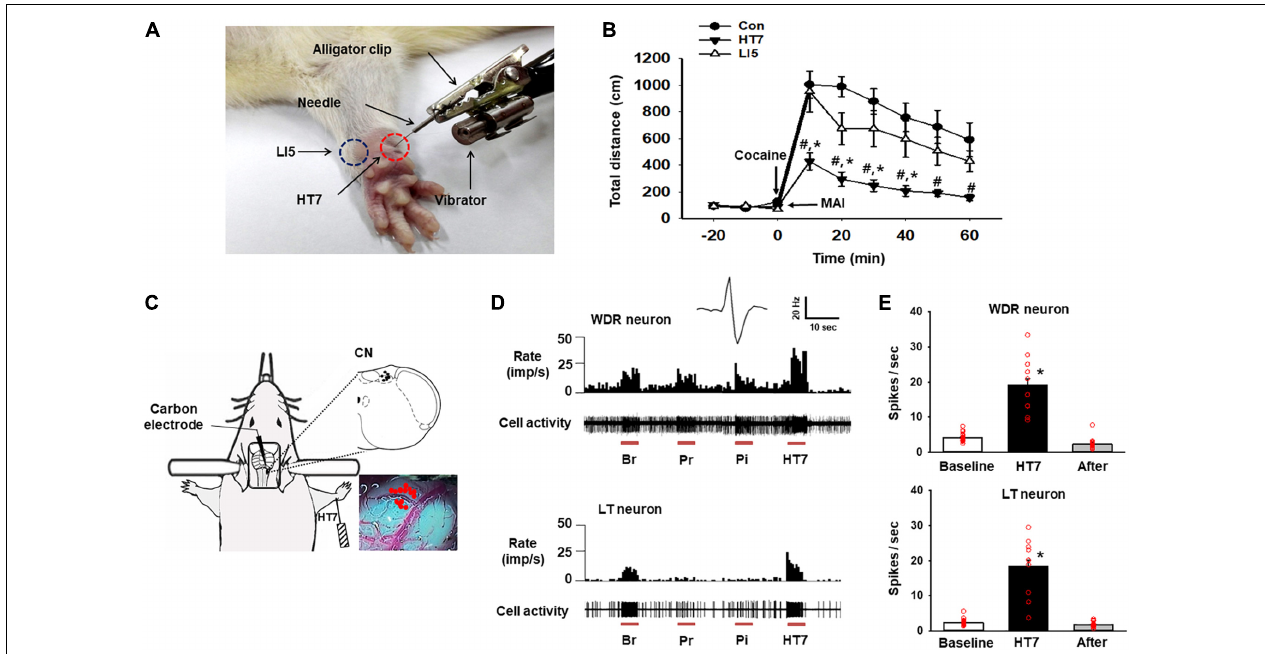
FIGURE 1 | Activation of the cuneate nucleus by mechanical acupuncture at HT7. (A) Acupuncture treatment at HT7 (red circle) or LI5 (blue circle) was performed by using our MAI. A bar-type cell phone motor was attached to an alligator clip to generate mechanical vibration of the needle. The intensity, frequency and operation time were controlled by a motor controller. (B) The effect of MAI acupuncture at HT7 or LI5 on cocaine-induced locomotor activity. Con, cocaine only ( n = 6); HT7, acupuncture at HT7 after cocaine injection ( n = 6); LI5, acupuncture at LI5 after cocaine injection ( n = 6). # p < 0.05 vs. Con, ∗ p < 0.05 vs. LI5 by two-way repeated ANOVA, Tukey’s post hoc test, interaction F = 2.647, p = 0.011; normality test (Shapiro–Wilk) passed, P = 0.747. (C) A schematic drawing of the in vivo extracellular recordings of the CN (cuneate nucleus). (D) The neuronal activity of wide-dynamic-range (WDR) and low-threshold (LT) neurons in response to brush (Br), light pressure (Pr) and pinch (Pi) mechanical stimulation of the somatic field and acupuncture stimulation at HT7 (HT7). (E) The mean firing rates of WDR neurons (upper panel), ( n = 12, ∗ p < 0.05 vs. Baseline by one-way repeated ANOVA, Tukey’s post hoc test, F (2,38) = 74.171, p < 0.001; normality test (Shapiro–Wilk) passed, P = 0.727) and LT neurons (lower panel), ( n = 15, ∗ p < 0.05 vs. Baseline by one-way repeated ANOVA, Tukey’s post hoc test, F (2,38) = 76.851, p < 0.001, normality test (Shapiro–Wilk) passed, P = 0.317) over 10 s before (Baseline), during (HT7), and after (After) acupuncture at